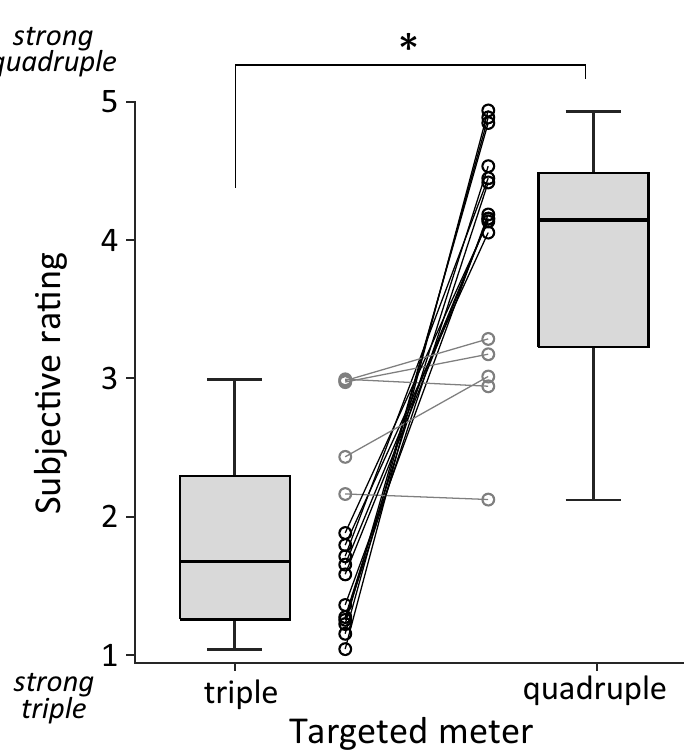
Fig 2. Mean subjective rating of triple- and quadruple-targeted trials. Participants ( n = 16) rated perceived meters from the biphasic stimuli on a five-point scale (from 1: “strong triple” to 5: “strong quadruple”). The rating score was relatively lower (more triple) for triple-targeted trials, and higher (more quadruple) for quadruple-targeted ones, suggesting that the listeners perceived different meters depending on the acoustic features which they attended. Gray circle and line indicate the five non-switchers. Asterisk ( � ) shows the significant difference ( p < 0.05).